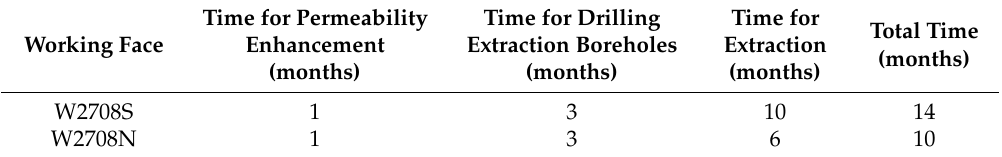
Table 1. Details of the time required to meet government